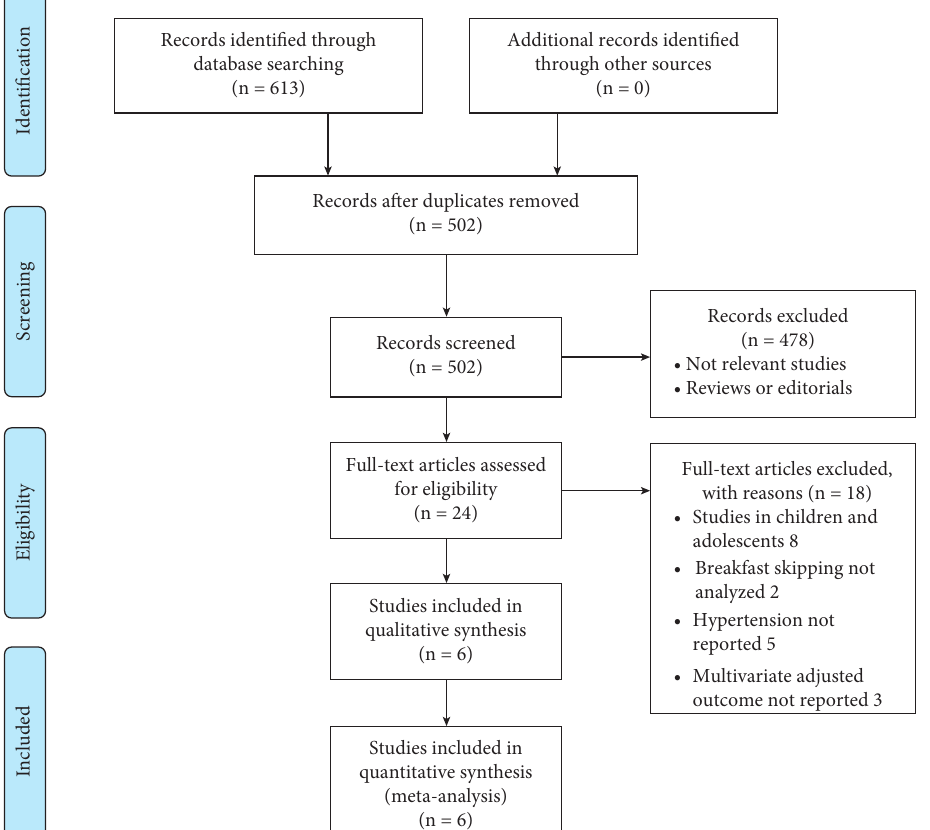
Figure 1: Flowchart of database search and study